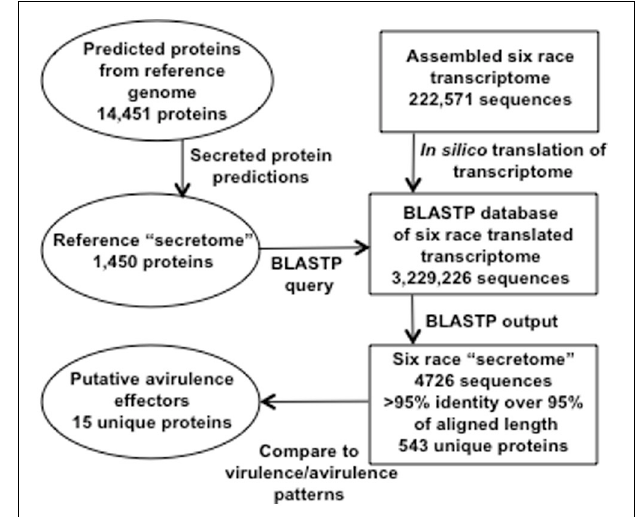
inoculation, before sporulating pustules appear. Races are listed at the top. Oil represents the oil only control.